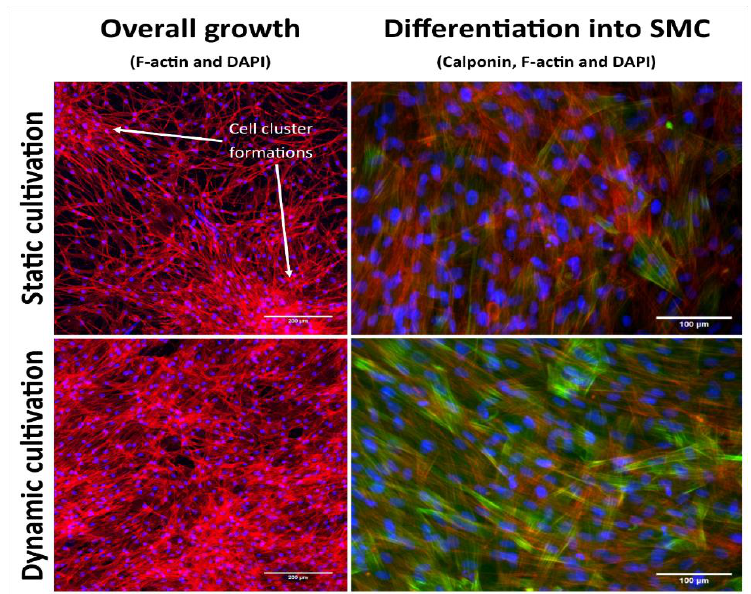
Figure 8. The number of cells in given depths of tissue in static and dynamic conditions with single side seeding. Statistical significance is for p < 0.05. Ten samples were taken for every type of cultivation and time interval. Each of the samples was sliced to 50 µm depth regions where cell numbers were counted. Red lines represent the median values; blue boxes 1st and 3rd quartiles; whiskers are the minimum and maximum; and the red circles are outliers.